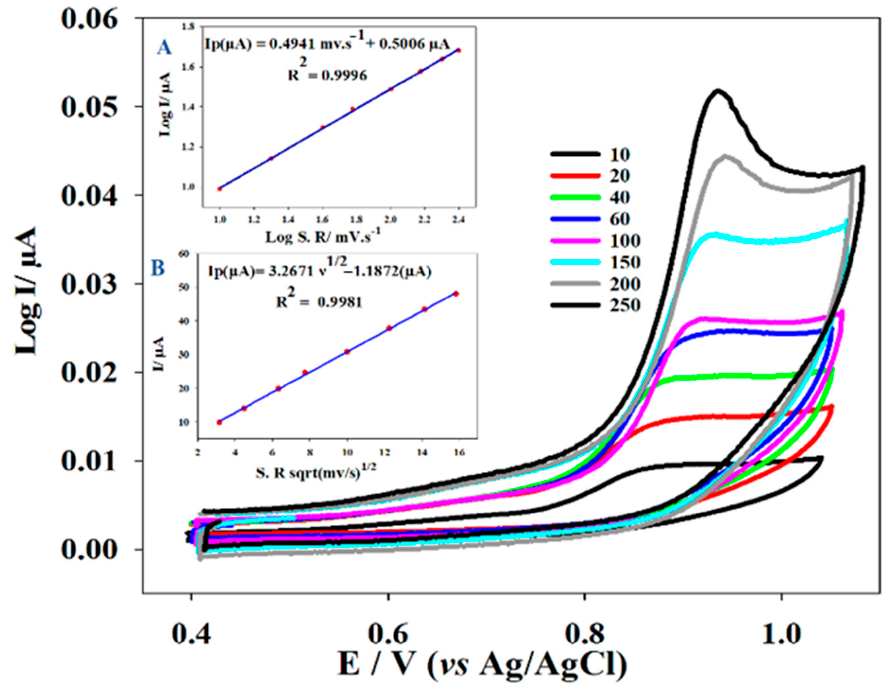
Figure 6. Cyclic voltammetry ( CVs)of 0.10 mM MTX at pH 7.0 using the g-CN/CPE in the wide scan rate (0.010–0.250 V s − 1 ) in pH 7.0 BRB. Insets: ( A ) plot of the log peak current vs log scan rate, and ( B ) plot of peak current vs the square root of the scan rate. ( B ) plot of peak current vs the square root of the scan